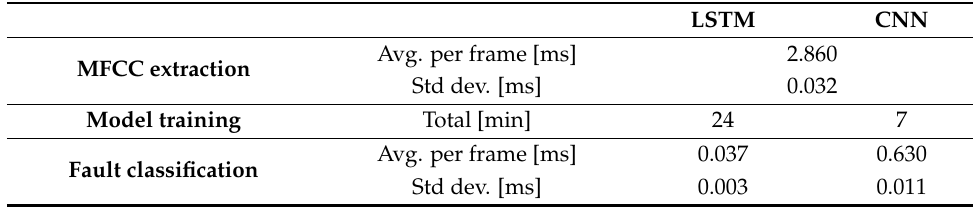
Table 9. Execution time for feature extraction, training and classification steps.